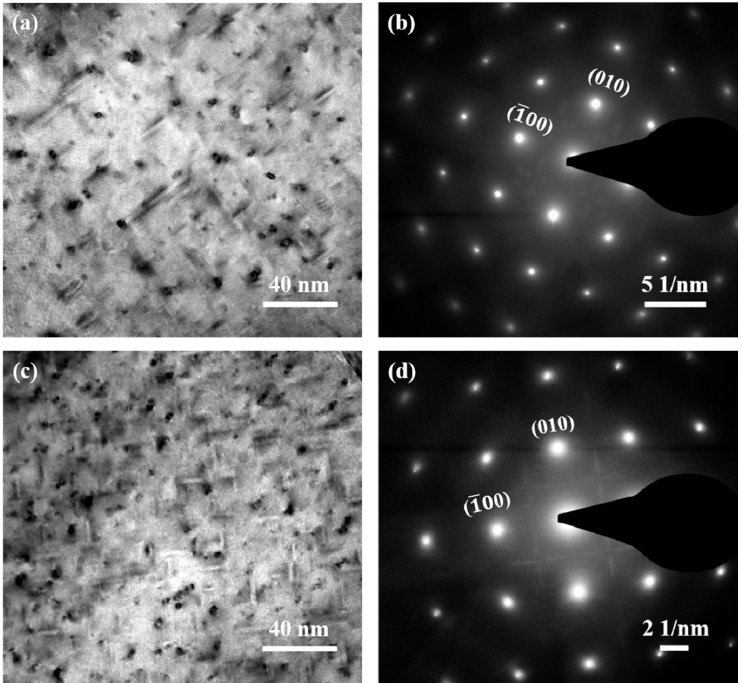
Figure 13. TEM images ( a ) bright field image of RH30-6H; ( b ) selected area diffraction pattern (SAPD) image of RH30-6H; ( c ) bright field image of IR30-6H; ( d ) SAPD image of IR30-6H.